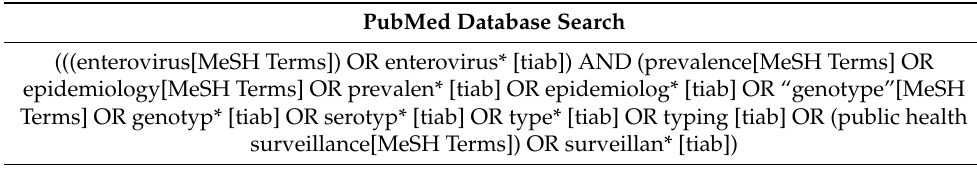
Table 2. Search as conducted in the PubMed Database on December 6th 2019. All identified publica- tions were screened and in- or excluded following the inclusion and exclusion